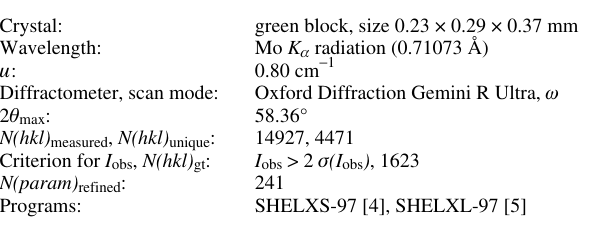
Table 1. Data collection and